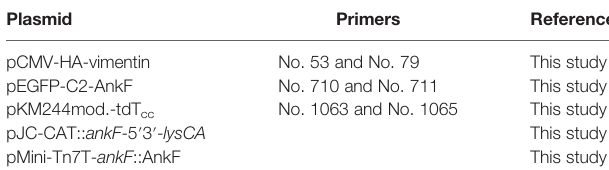
TABLE 2 | Plasmids constructed in this